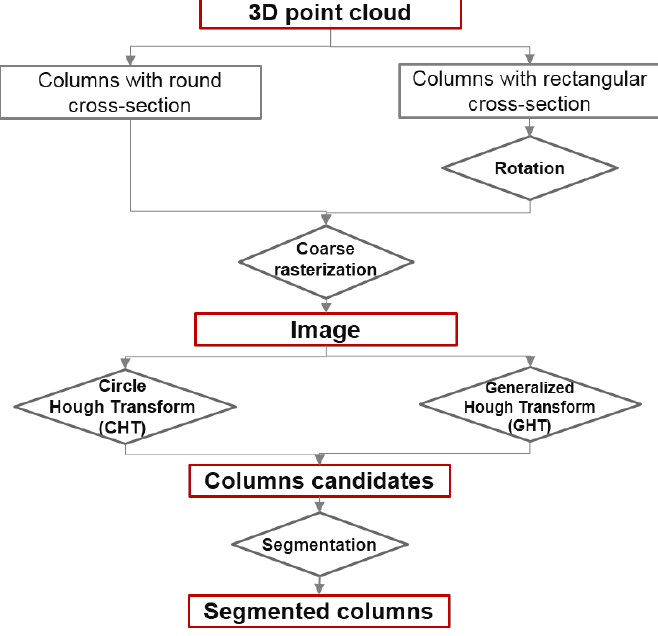
Figure 1. Schema of the methodology proposed for column detection and